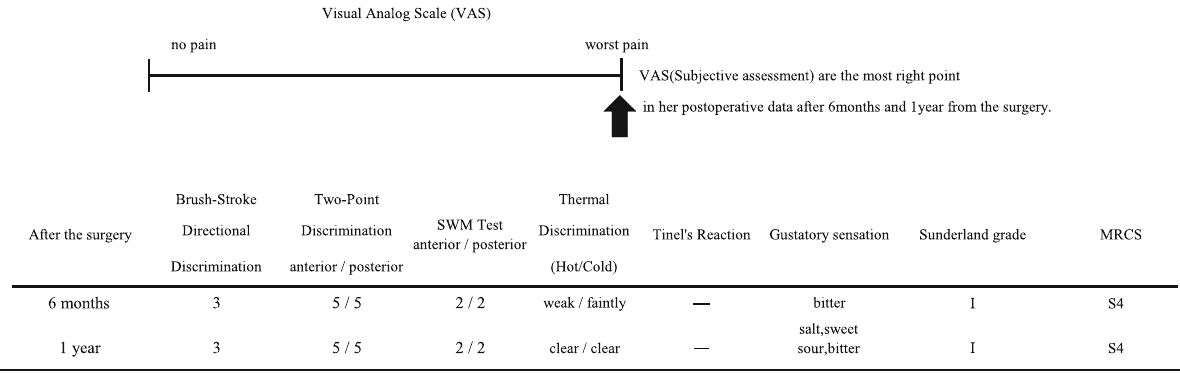
Table 2 Postoperative data of visual analog scale and another various assessments